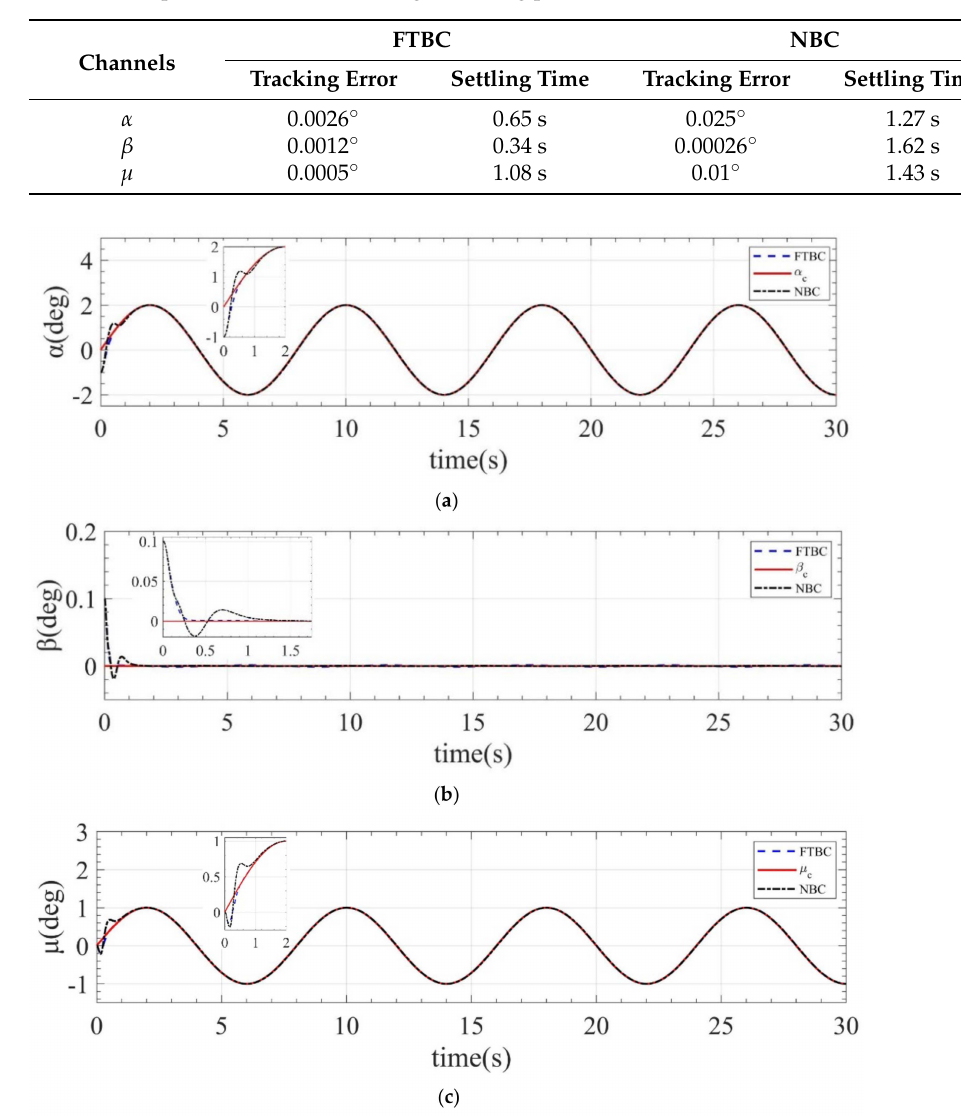
Figure 10. ( a ) Tracking curve of α , ( b ) tracking curve of β , and ( c ) tracking curve of µ